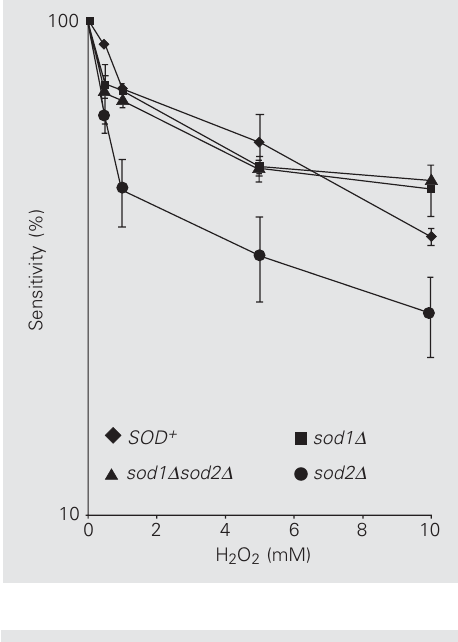
Figure 2. Activity of catalase and glutathione peroxidase in un- treated wild-type and sod mu- tant cells. Data are reported as the mean ± SD of three inde- pendent experiments. *P < 0.05 compared to SOD + (Student t -